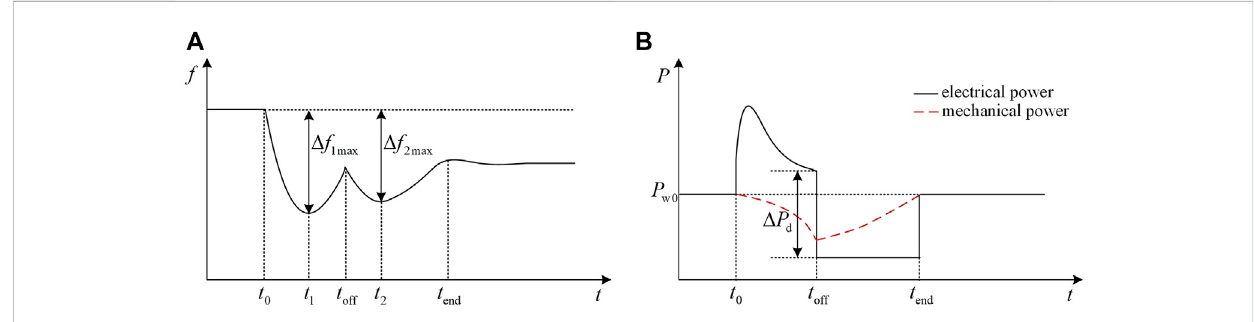
FIGURE 2 (A) Schematic diagram of the SFD. (B) Power output curves of